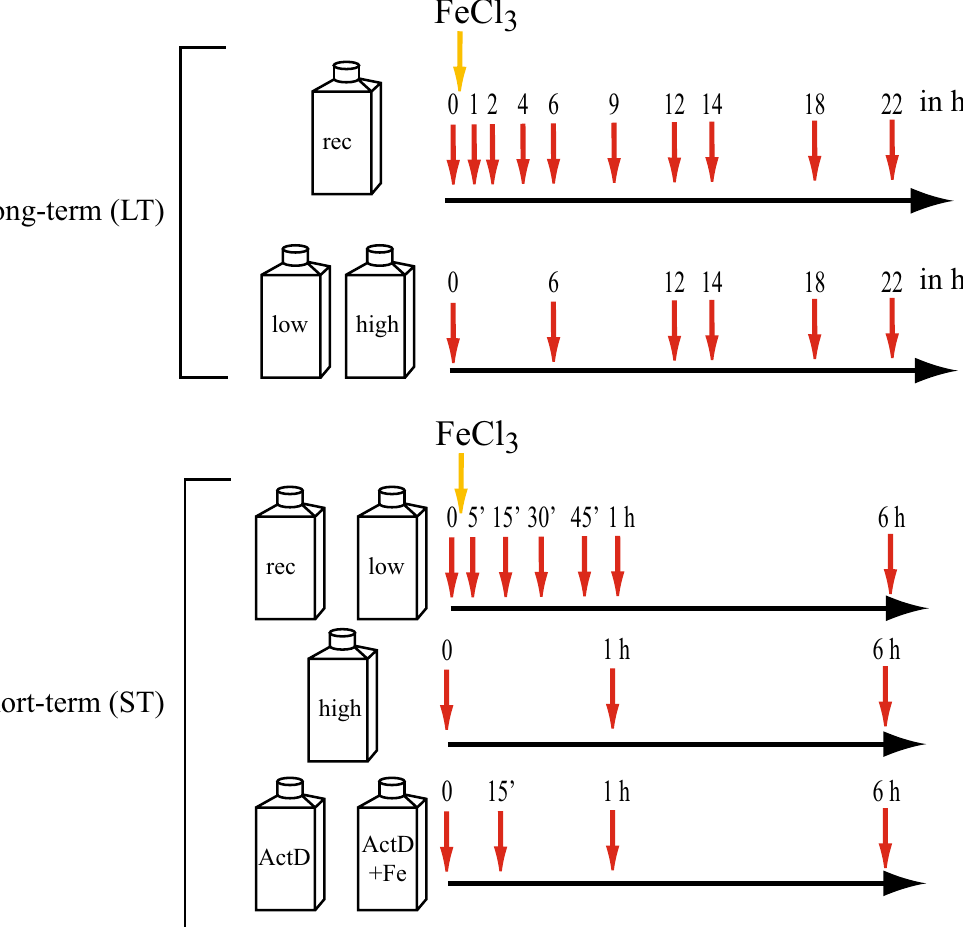
Figure 6. Experimental overview with sampling times. Shown are the two different experiments that were conducted, the long-term (LT) experiment and the short-term (ST) experiment. The bottles indicate the different treatments that were analyzed in each experiment. Beside the bottles are the sampling times in hours (h). The addition of iron is indicated with a yellow arrow. The iron-recovery (rec) and the ActD+Fe samples were the only samples that received the addition of FeCl 3 as